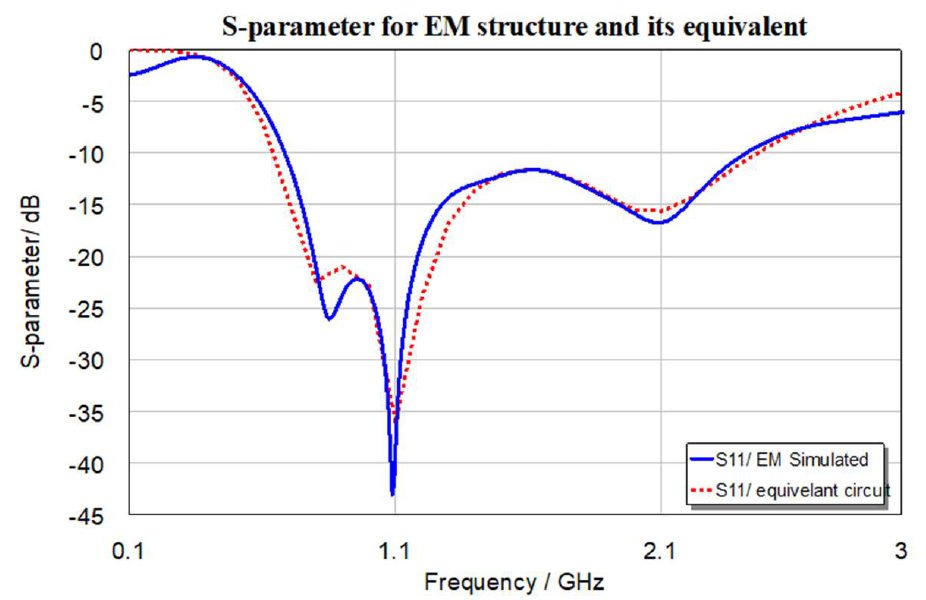
Figure 9. S11-parameter for wideband biconical antenna and its equivalent circuit. Table 2. The optimum values of the lumped elements.